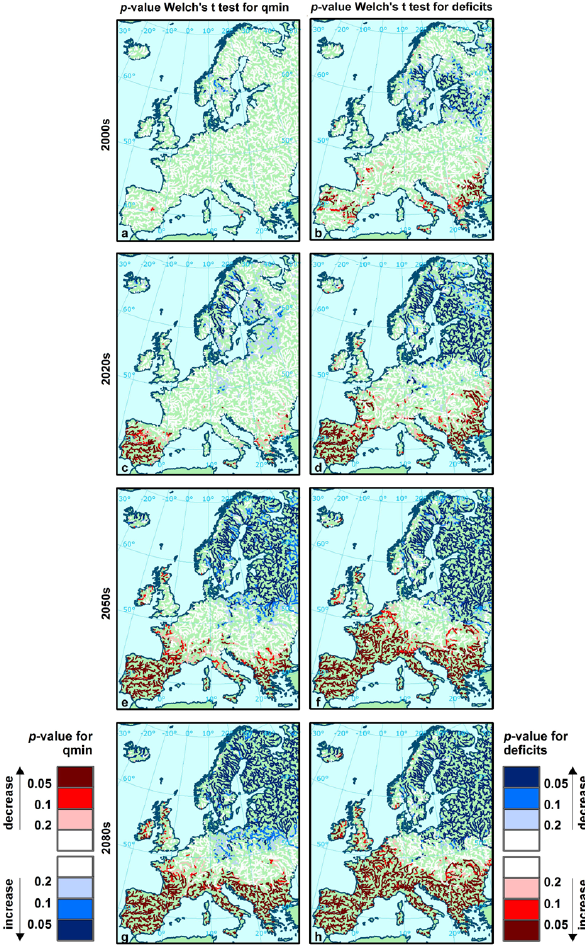
Fig. 11. p value to test significance of the average change in min- imum flows (left) and deficit volumes (right) between the corre- sponding time slices and the control period (1961–1990). p values are obtained on the basis of Welch’s t